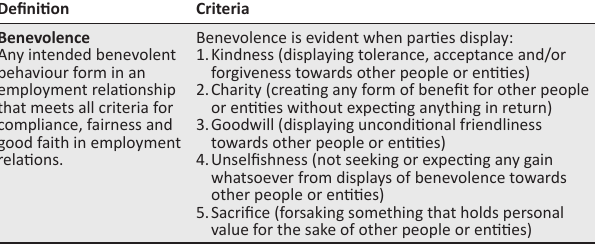
TABLE 2: Employment relations benevolence. Definition